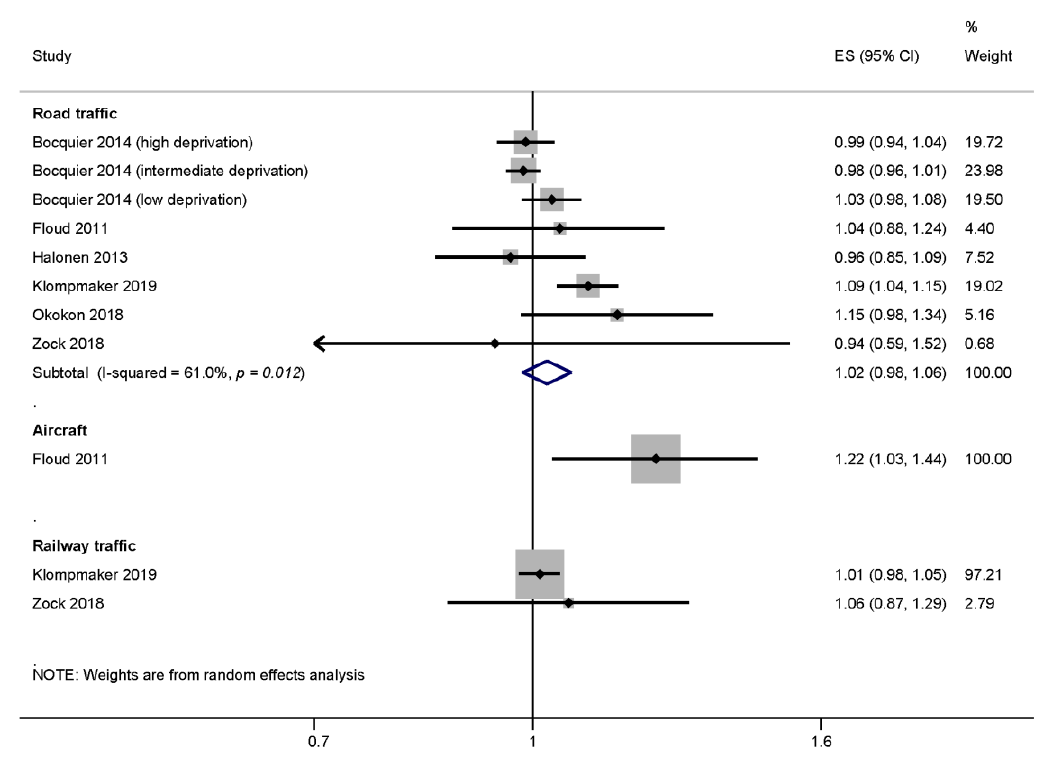
Figure 3. Forest plots of various noise sources and the estimates of effect size (ES) for anxiety (based on anxiolytics use, diagnoses, detected with a validated screening instrument). All ES were converted to represent the risk per 10 dB L DEN .